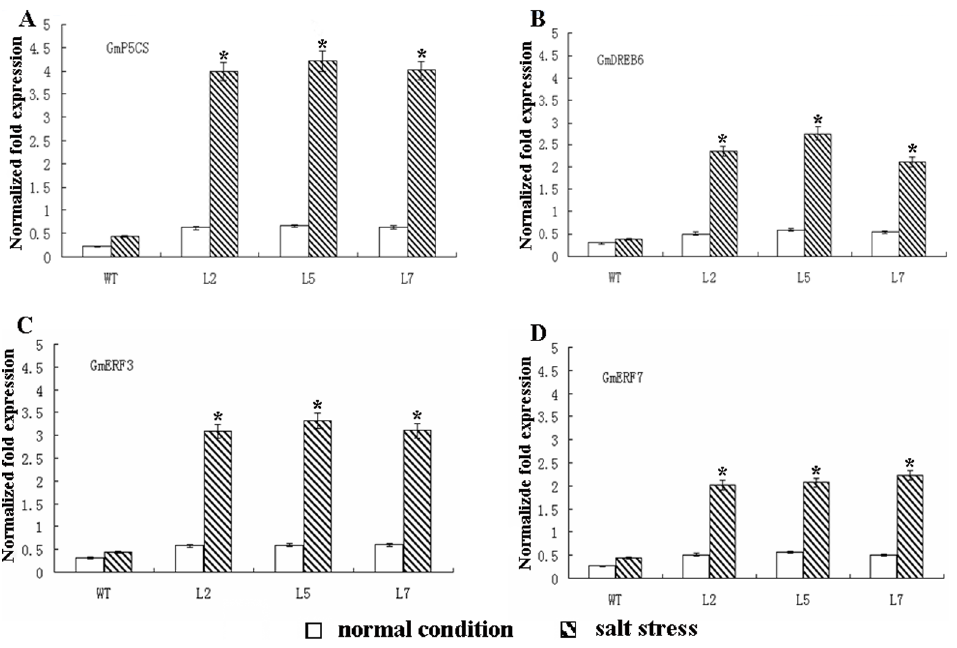
Figure 3. Expression patterns of salt stress-response genes. Tubulin was used as an internal control. Four genes, GmP5CS , GmDREB6 , GmERF3 , and GmERF7 showed increased expression levels in the transgenic soybeans compared to the WT. Values are the mean of four biological replicates 6 SE.